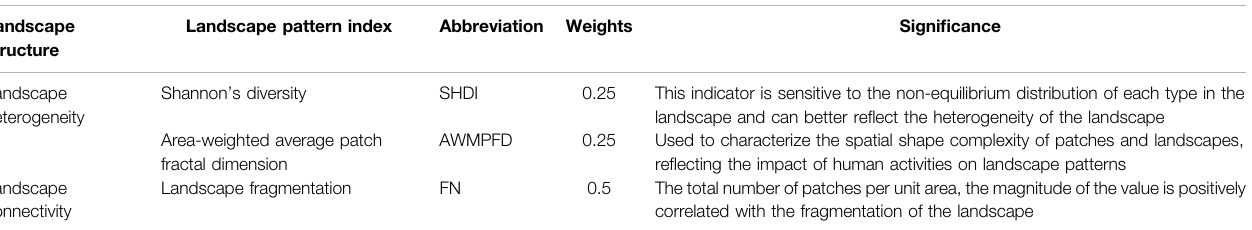
TABLE 4 | Landscape pattern index, weight, and